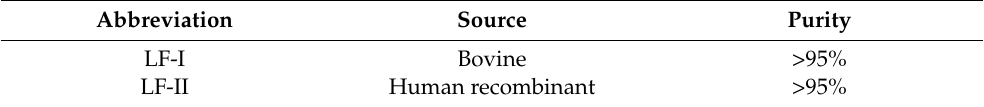
Table 1. Sources of the two types of lactoferrin (LF) used in this study and the purity of the concen- trations